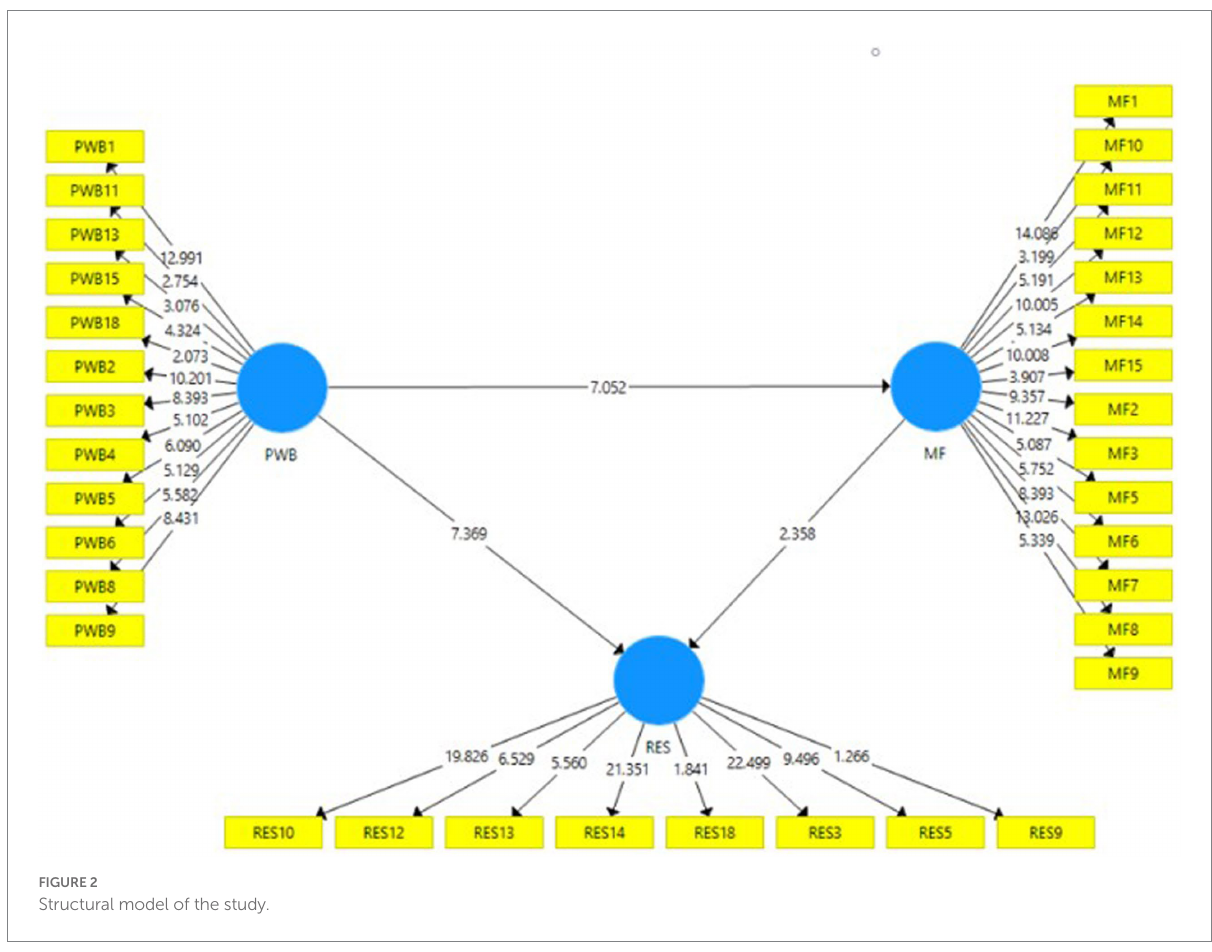
FIGURE 2 Structural model of the study.